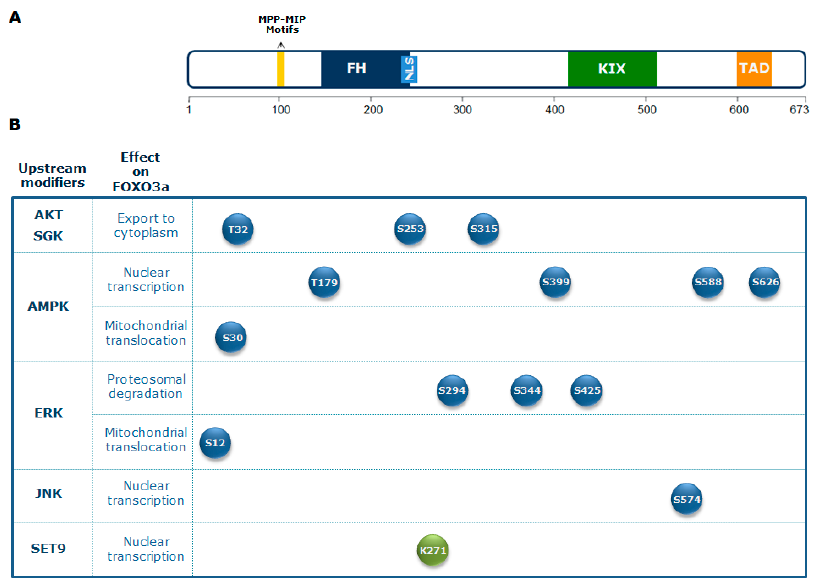
Figure 1. Post-translational regulation of FOXO3a. ( A ) Schematic representation of FOXO3a domains (MPP-MIP motifs, consensus motifs for mitochondrial processing peptidase (MPP) and mitochondrial intermediate peptidase (MIP); forkhead domain, FH; nuclear localization signal, NLS, Kinase-inducible domain interacting domain binding domain, KIX; transactivation domain